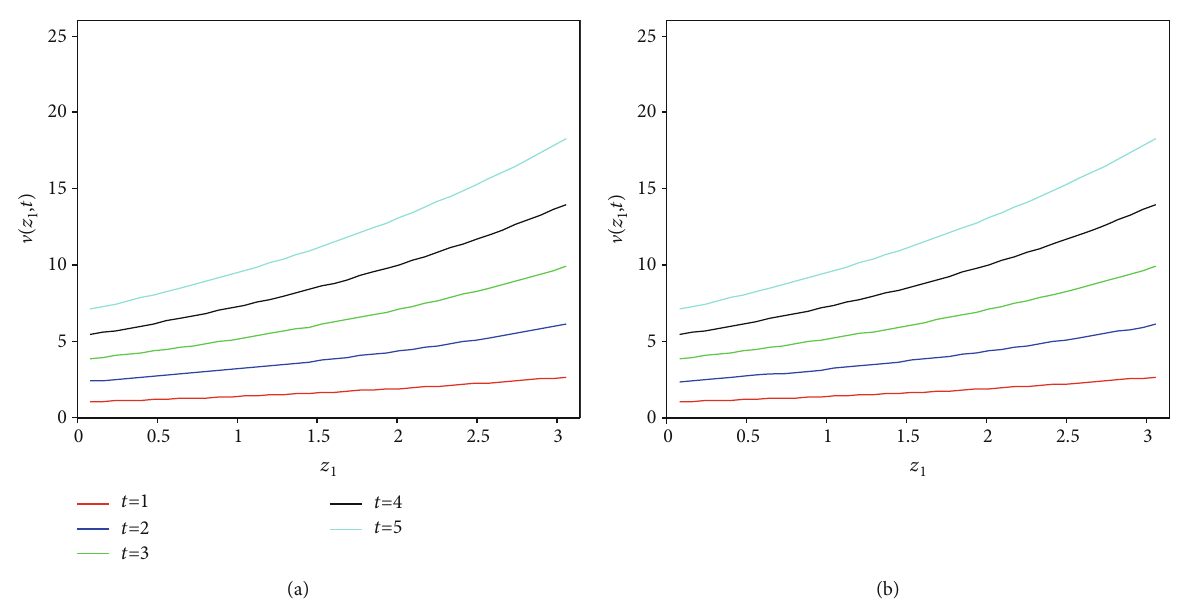
Figure 5: Approximate solution at di ff erent time levels by using (a) IS and (b) CNS for the Problem